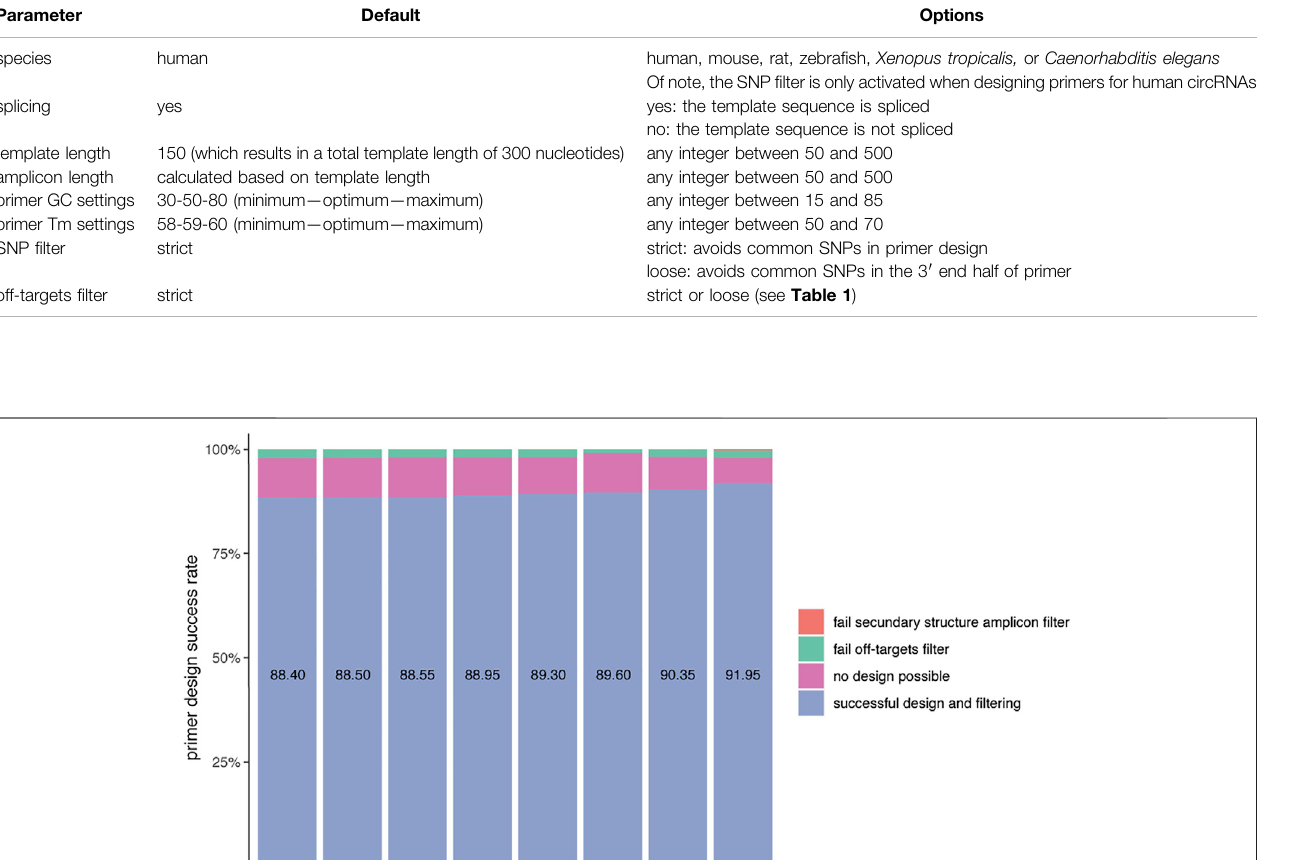
TABLE2| CIRCprimerXLwebtoolparameters.CIRCprimerXLtakesmultipleparameterstoadjustthespecies,inputtemplateandampliconsize,GCantTmprimersettings, SNP, and speci fi city evaluation. Parameter